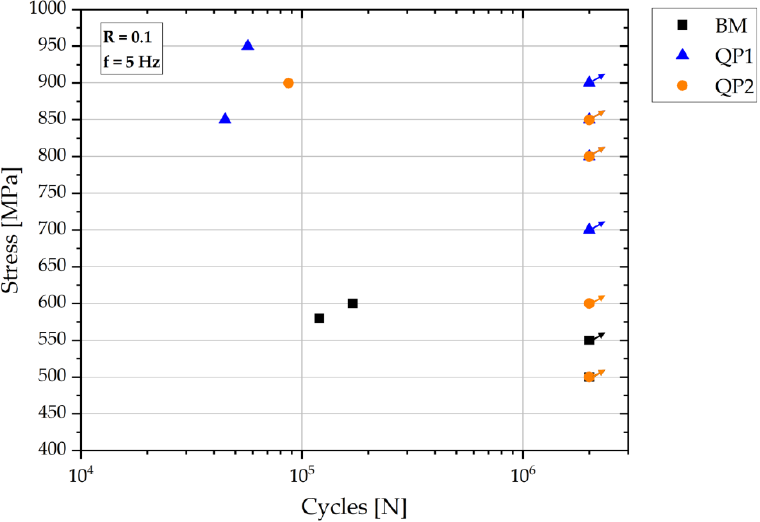
Figure 10. S-N diagram of the investigated constant amplitude tests for BM, QP1, QP2.